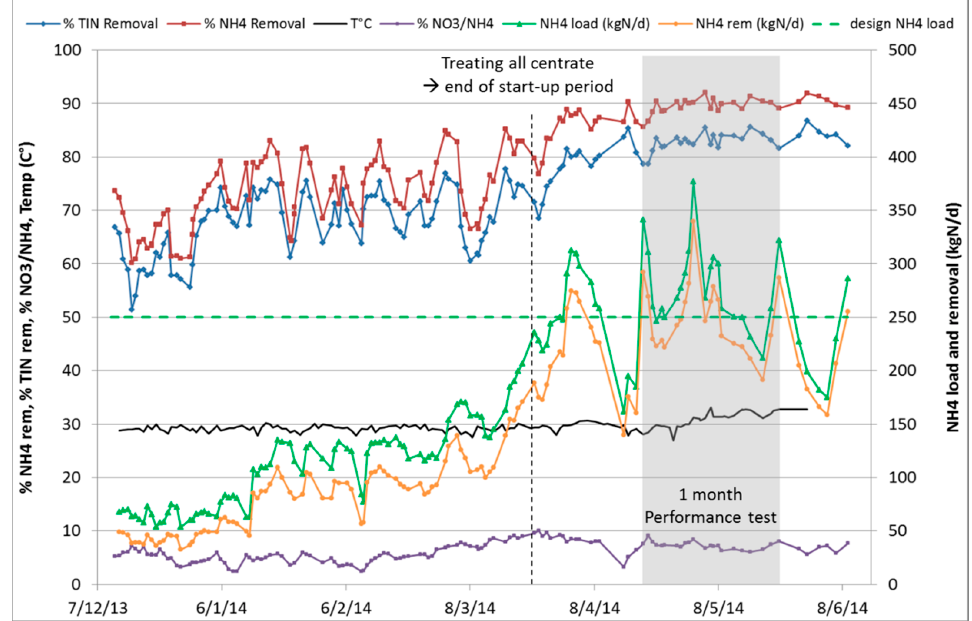
Figure 2. ANITA Mox start-up performance adapted from [8]. TIN (Total Inorganic Nitrogen) = NH 4 + NO 3 + NO 2 .